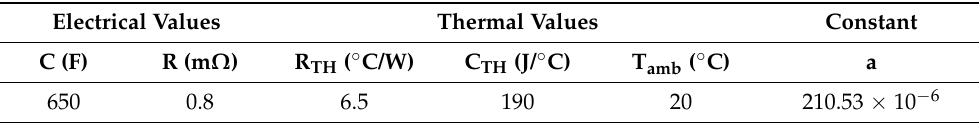
Table 1. Parameters of the cell under